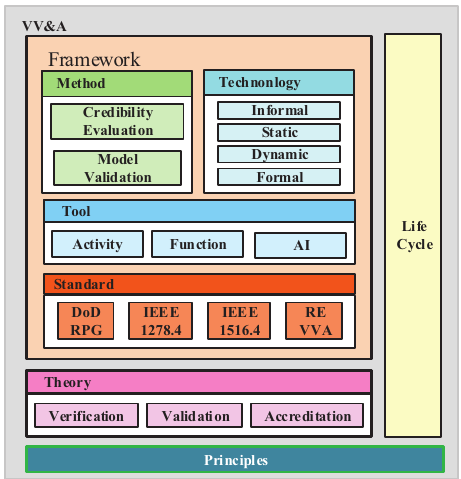
Figure 2. The content structure of